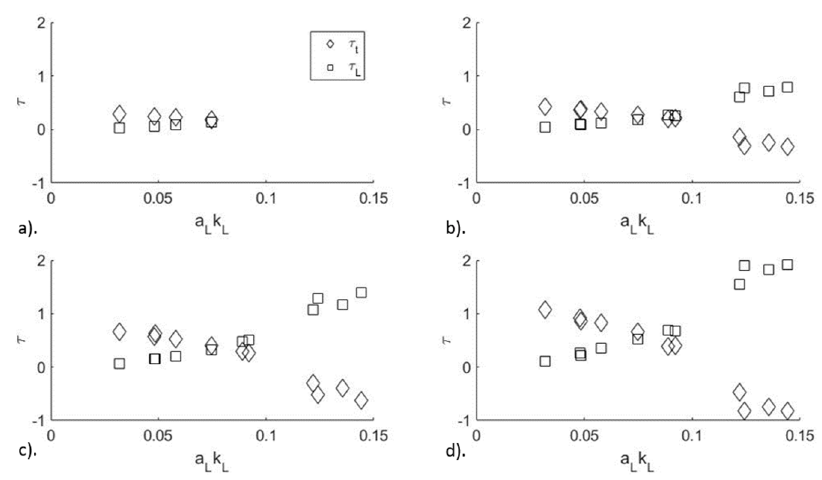
Figure 8. Modified model results for τ t and τ L as a function of a L k L for ( a ) U = 5.5 m / s, ( b ) U = 7 m / s, ( c ) U = 8.5 m / s, and ( d ) U = 10 m / s.